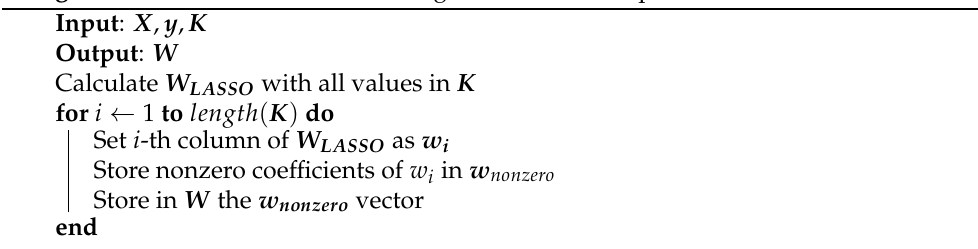
Algorithm 6: Least Absolute Shrinkage and Selection